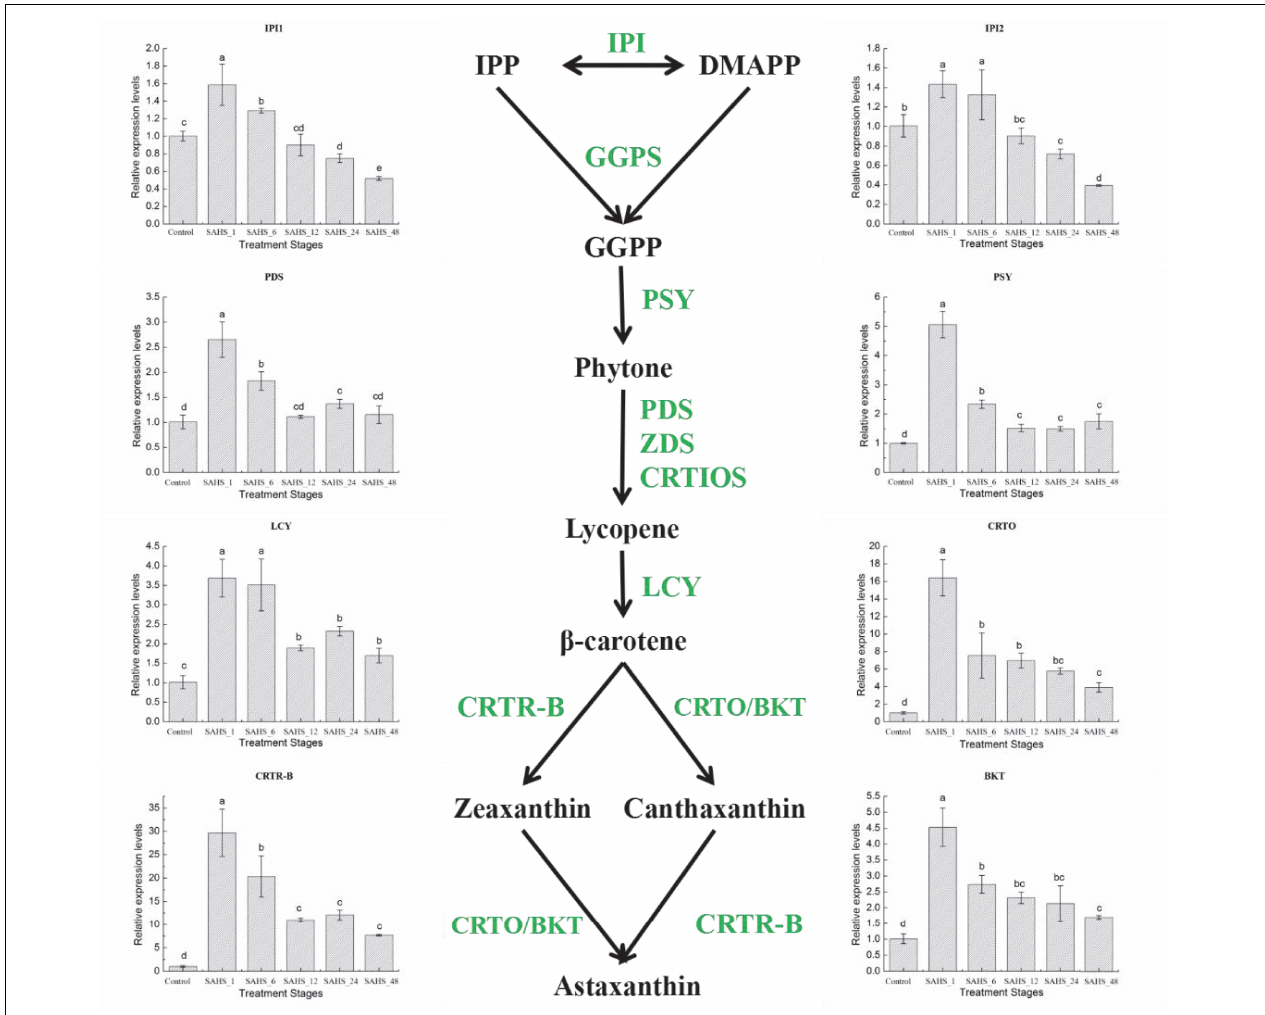
FIGURE 4 | Expression of genes in the H. pluvialis astaxanthin biosynthesis pathway under different treatment stages. Lower case letters indicate significant differences ( p < 0.05) among the